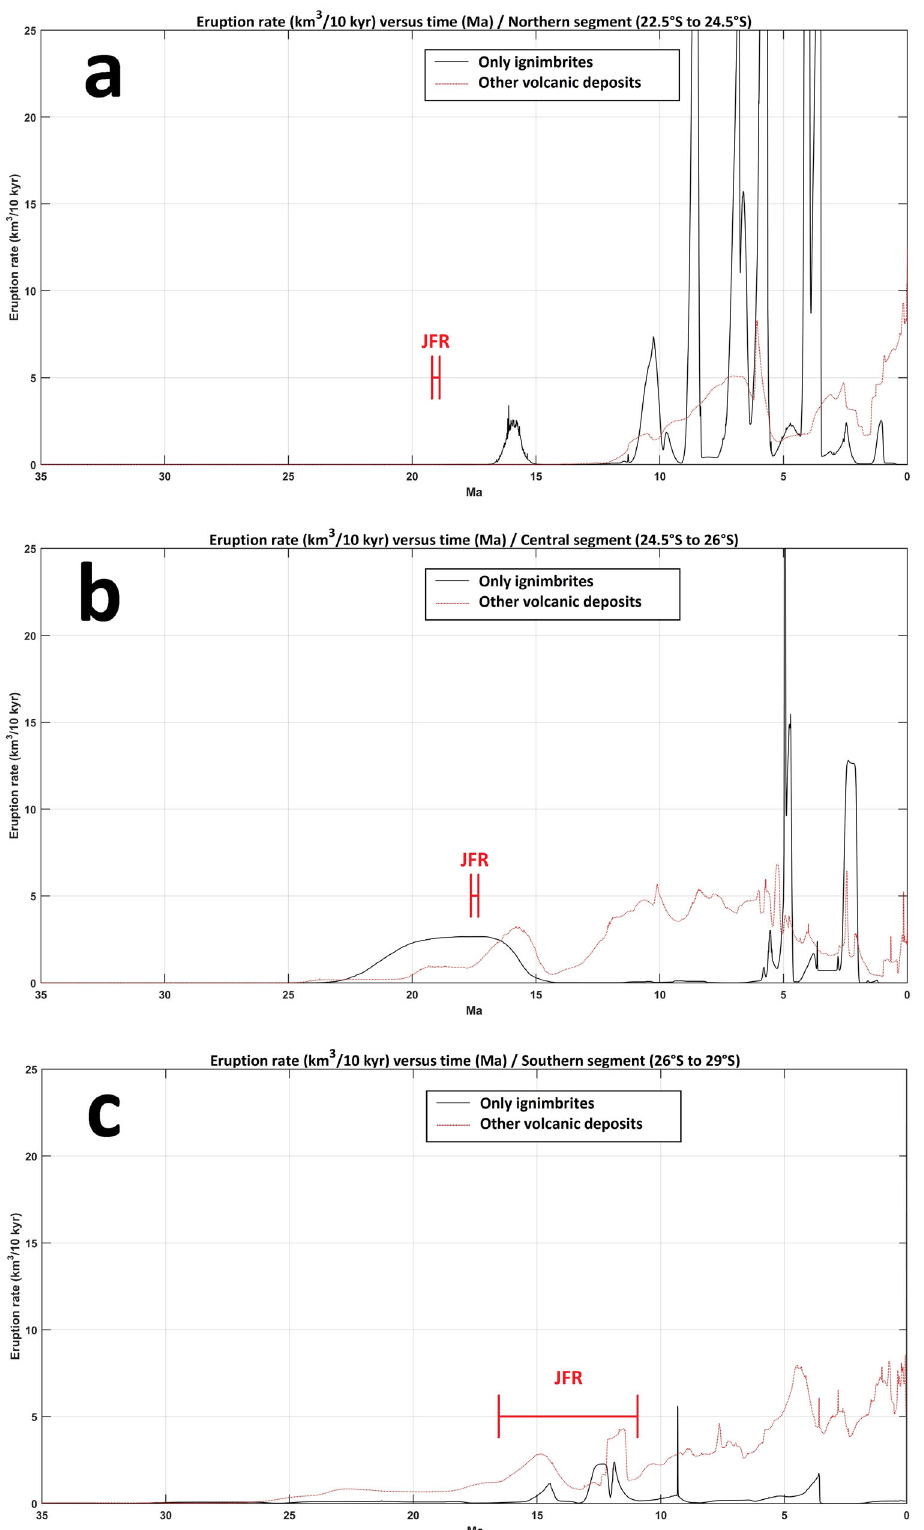
Fig. 3 Eruption rates for ignimbrites (black line) and other volcanic deposits (red dashed line) analyzed along three segments of latitude. a Northern segment (22.5 – 24.5°S). b Central segment (24.5 – 26°S). c Southern segment (26 – 29°S). In each fi gure, the red bracket speci fi es the time when the collision point of the Juan Fernández Ridge (JFR) against the continental margin moved south of each arc segment according to the two ridge models of Bello-González et al. 51 . For example, in the lowermost fi gure, the Juan Fernández Ridge moved south of ~29°S sometime between 17 and 11 Ma.